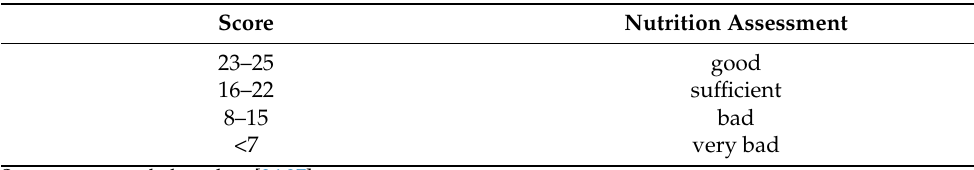
Table 3. Evaluation of the modified Starzy´nska’s